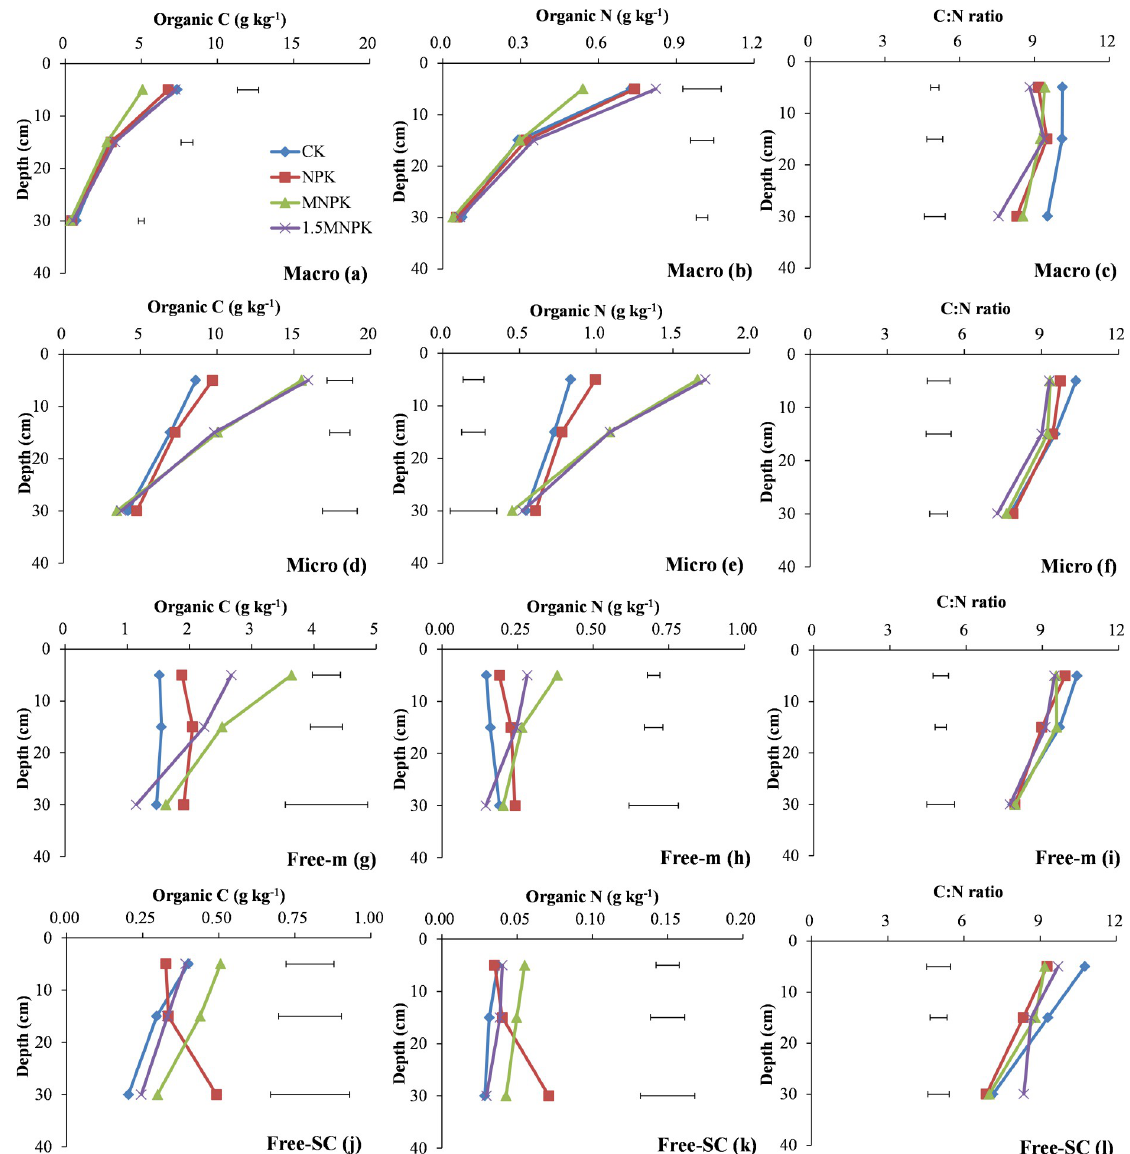
Fig 2. Change in organic C and N concentrations and their C/N ratios in water stable aggregate fractions (WSA) of control (CK), chemical fertilizer (NPK), and combined manure and chemical fertilizer (MNPK, 1.5MNPK) treatments in the top 40 cm of the soil profile. Values at each soil depth are the mean of three replicates. The horizontal lines denote the least significant difference values at the 0.05 level (LSD0.05) among different treatments at each soil depth. Symbols of aggregate fractions: see Fig 1